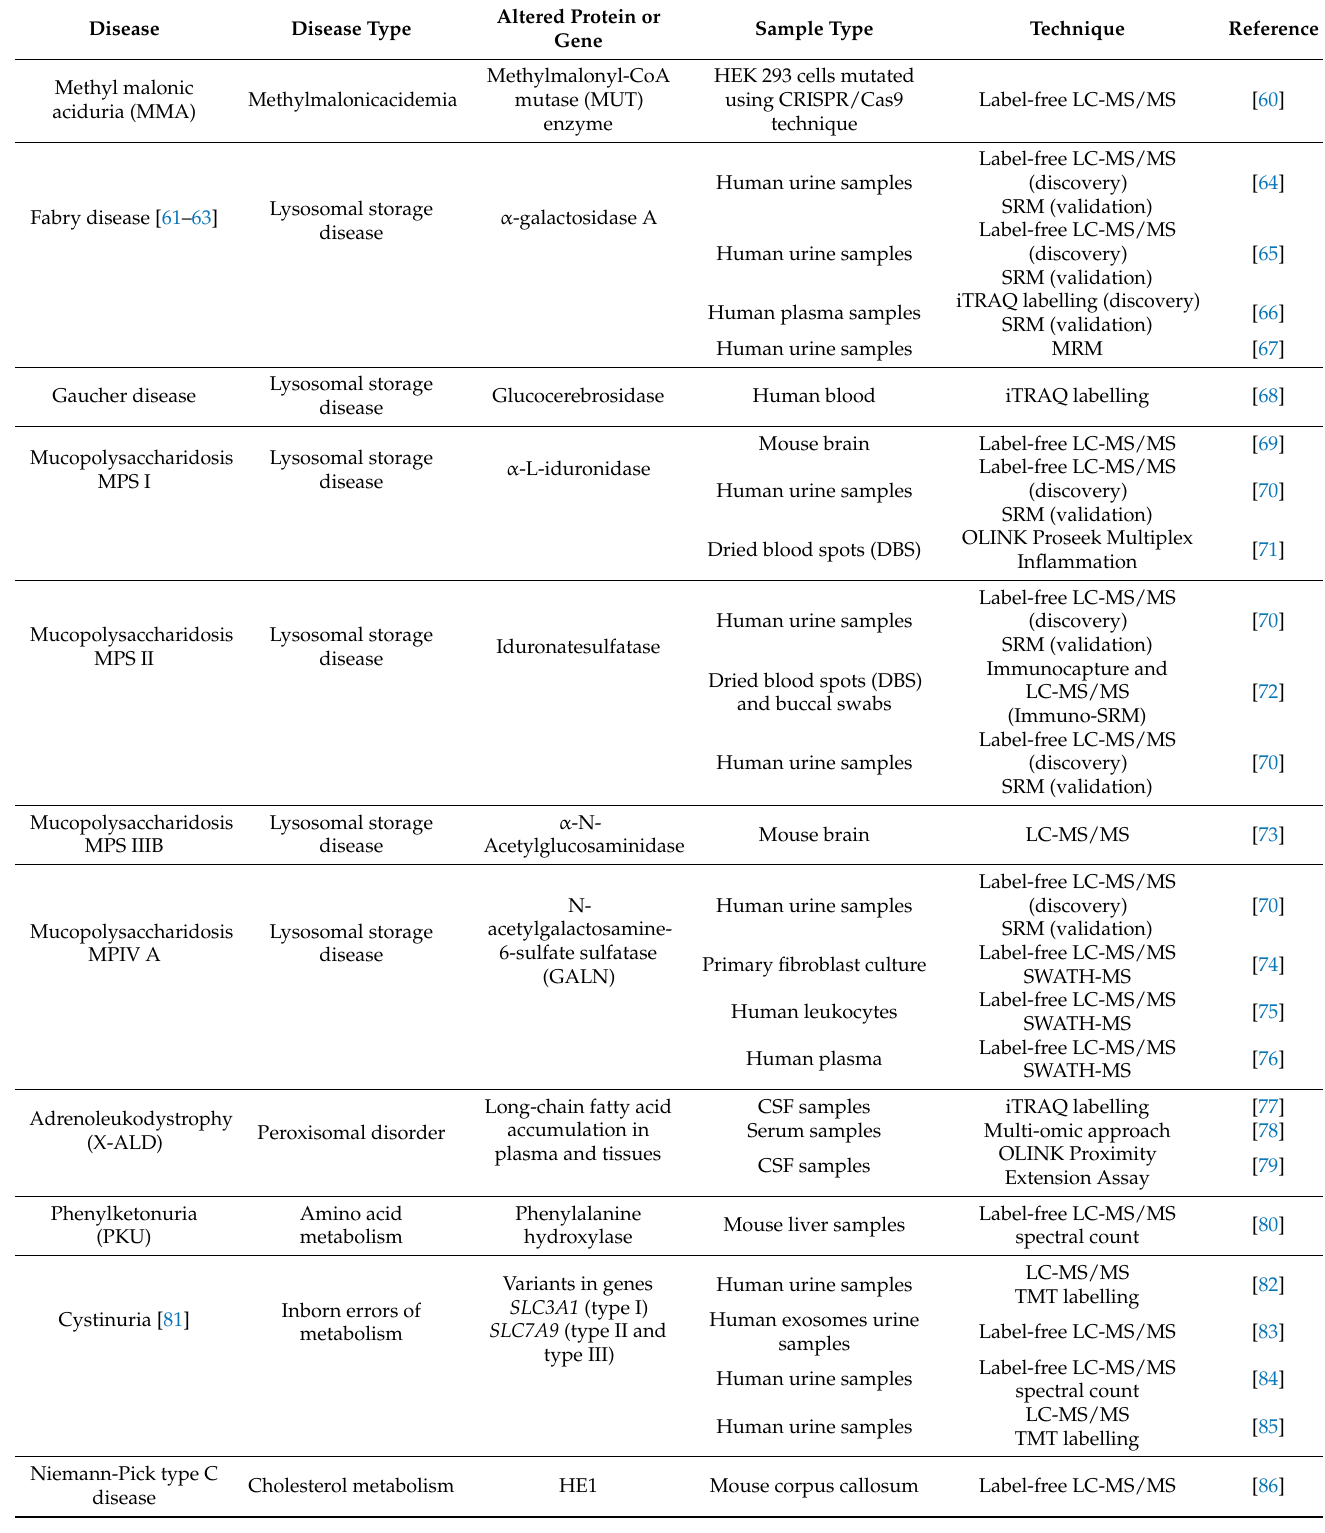
Table 1. Overview of recent proteomics analyses of rare genetic metabolic